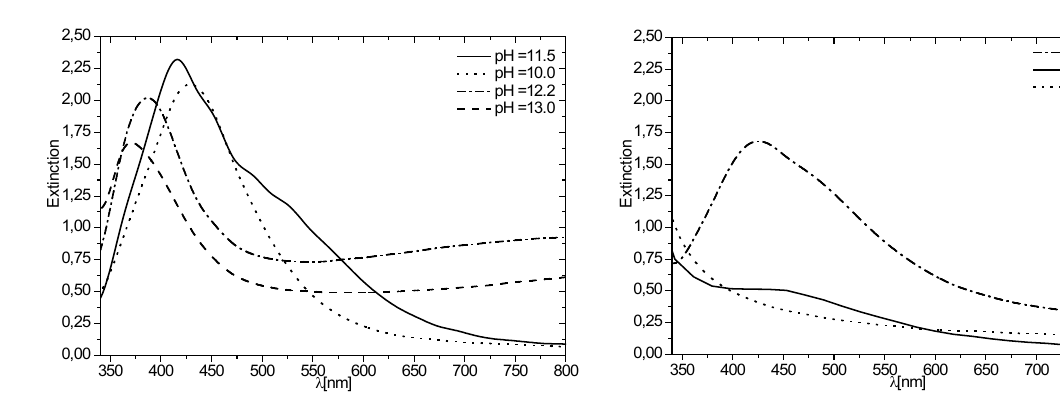
Figure 5. UV-Vis spectra recorded during the reduction of AgBr crystals in the presence of ascorbic acid, with an AgBr to ascorbic acid molar ratio of 1:3.0, various pHs and without exposition to